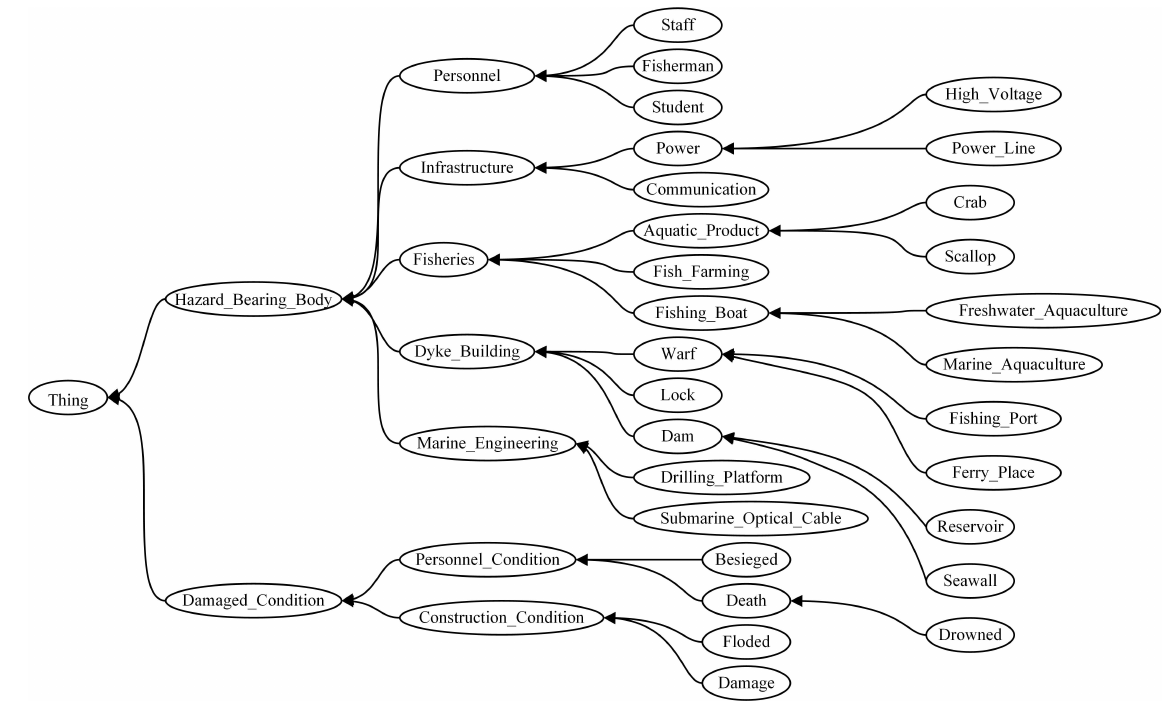
Figure 4. The concept of storm surge disaster domain